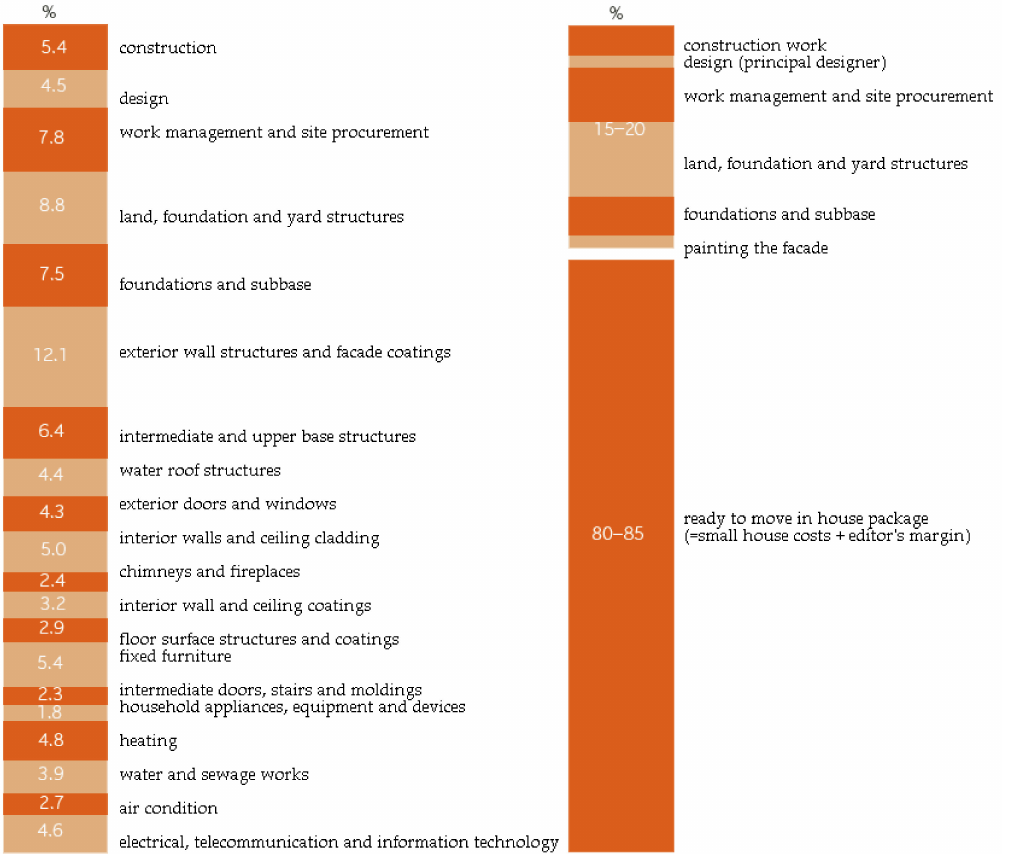
Figure 7. The breakdown of the average small house project costs.